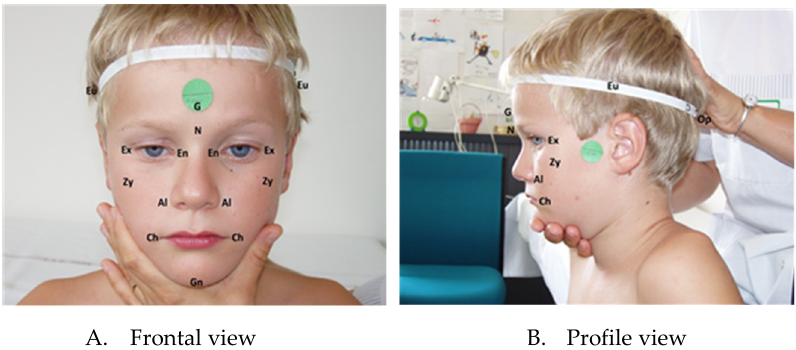
Figure 1. Standardized cranio-facial photographs with the camera lens aligned with the subject’s Frankfort horizontal plane and with an internal measure of scale (adhesive paper sticker) placed on the glabella landmark for the frontal view and on the condylion of the mandible for the profile view.